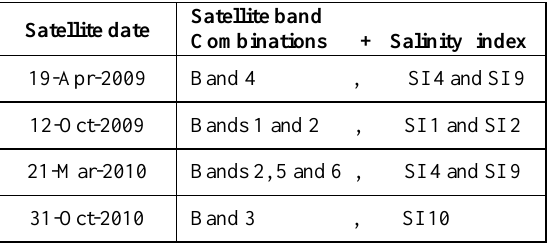
Table 5. Global standard salinity